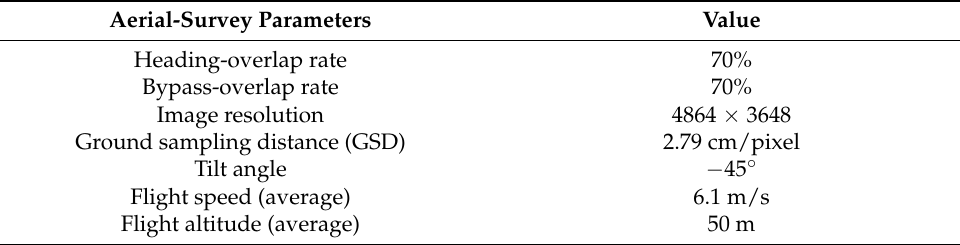
Figure 3. UAV measurement area: ( a ) location of Liaoning Province on the map of China; ( b ) location of Anshan City in Liaoning; ( c ) satellite images of the study area; ( d ) camera images of the study area. Table 2. UAV aerial-survey parameters.